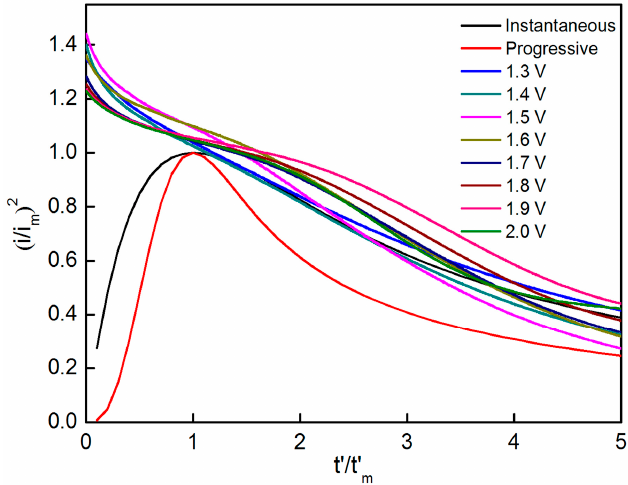
Figure 8. Comparison of dimensionless (i/i m ) 2 vs. t’/t’ m plots of nucleation process on graphite flake at various potentials (1.3 V to 2.0 V).